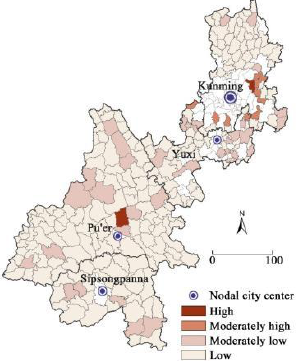
Figure 3. Comprehensive assessment